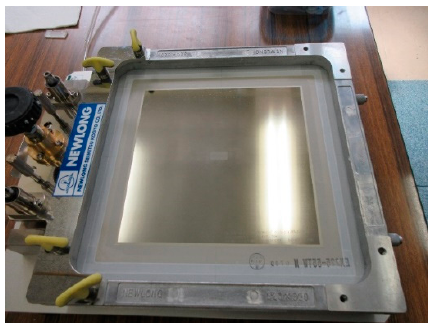
Figure 2. Appearance of screen-printing system.